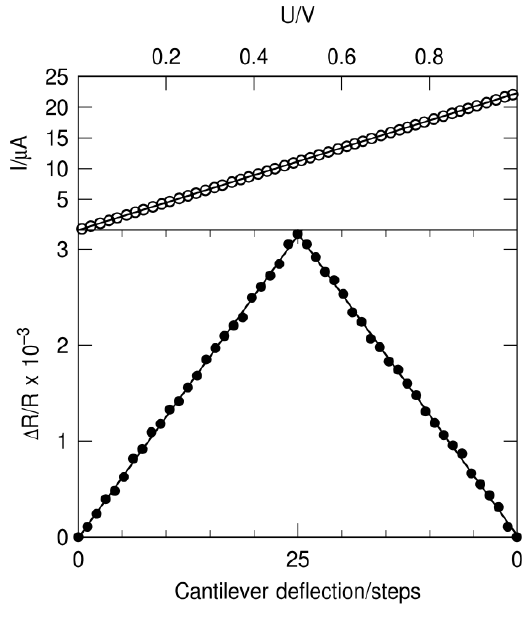
Figure 3. Top: Exemplary I(V)-characteristic for deposited strain sensor; Bottom: Exemplary  R/R vs. cantilever deflection curve used for measuring the deflection sensitivity. One deflection step corresponds to a deflection of the cantilever of 164